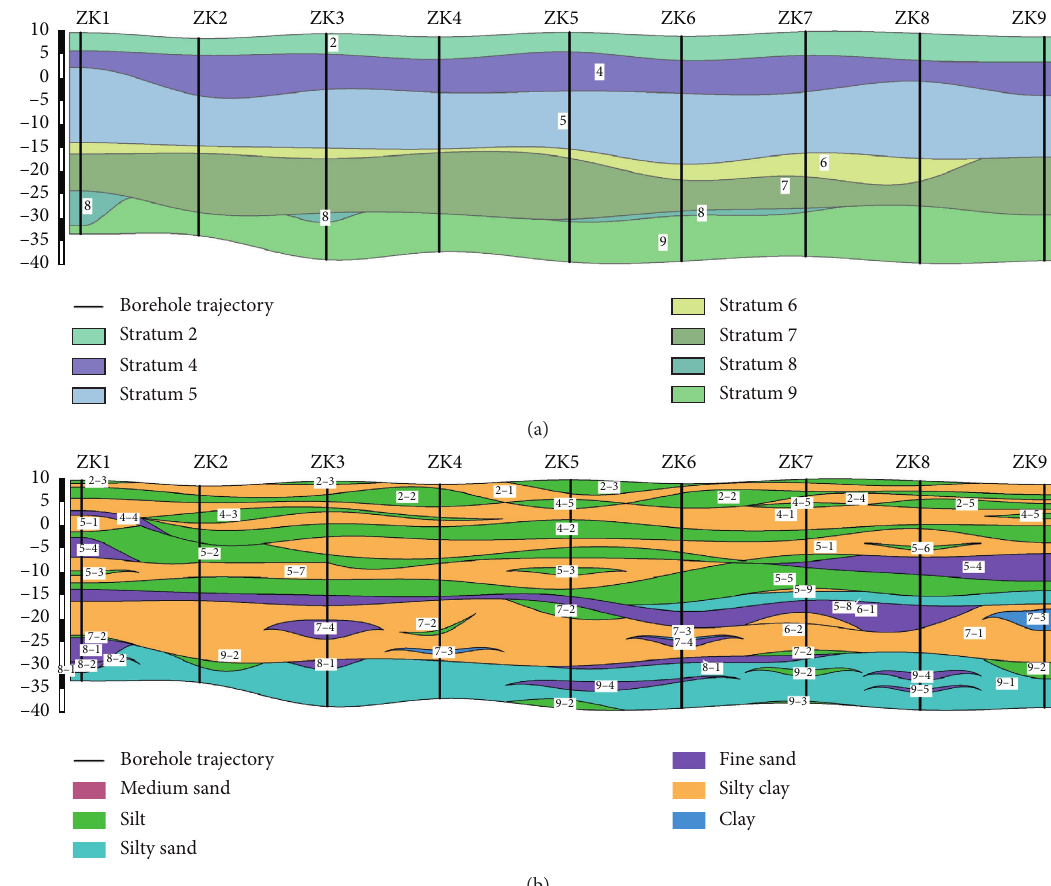
Figure 12: The engineering sections drawn by the proposed method on a regional scale: (a) section of 1st stratigraphical column and (b) section of 2nd stratigraphical